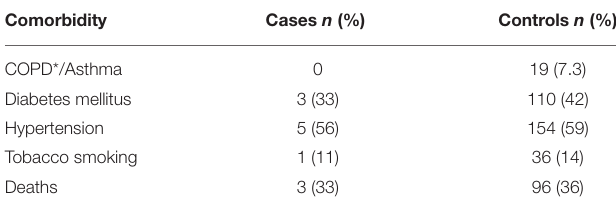
TABLE 4 | Frequency of comorbidities in cases and